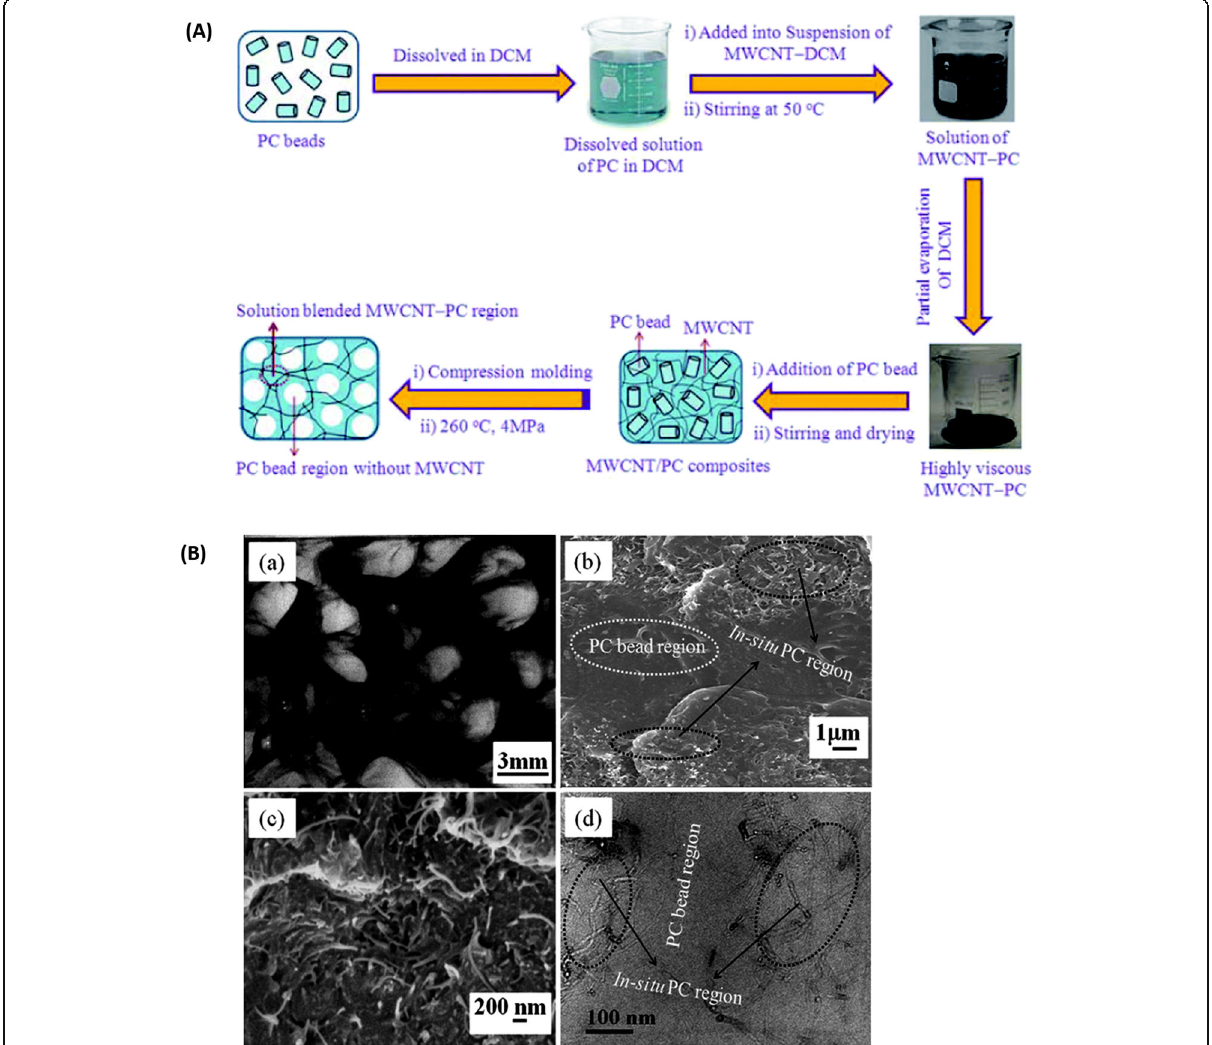
70wt% PC bead and 0.10wt% CNT loading. Reprinted with permission from Khatua et al. [73], copyright 2014 Royal Society of